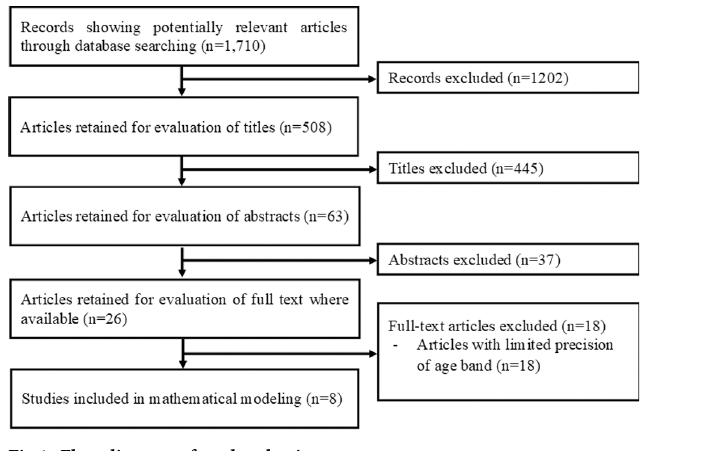
Fig 1. Flow diagram of study